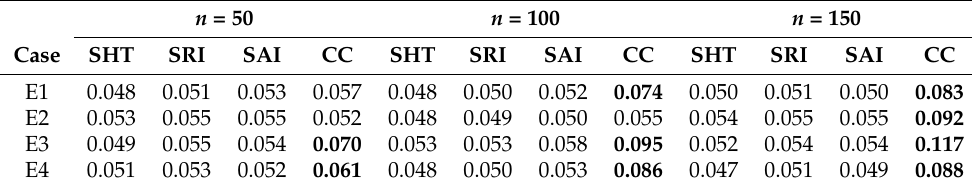
Table 1. Empirical type I error rates for balanced designs in the first simulation study.